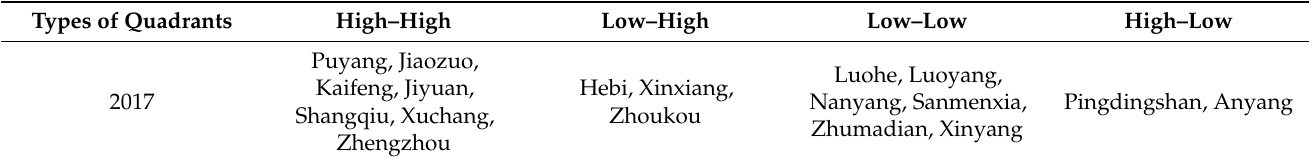
Table 1. Spatial clustering of PM 2.5 concentrations in Henan Province,